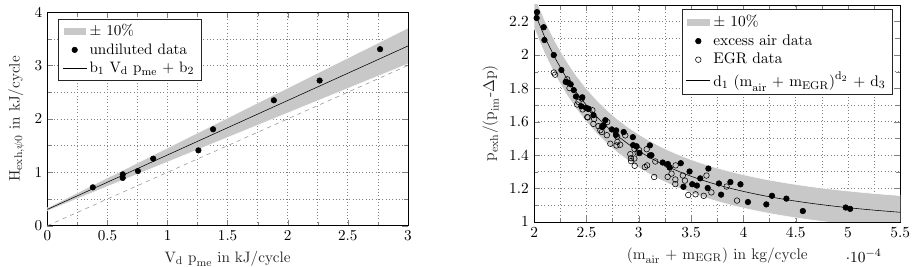
Figure 6. ( Left ) The undiluted exhaust enthalpy H exh , ψ as an affine function of the mechanical energy 0 p me ; ( Right ) The exhaust-to-intake pressure ratio as a function of the cylinder released per cycle V d · massflow. The data contains measurements with excess air as well as